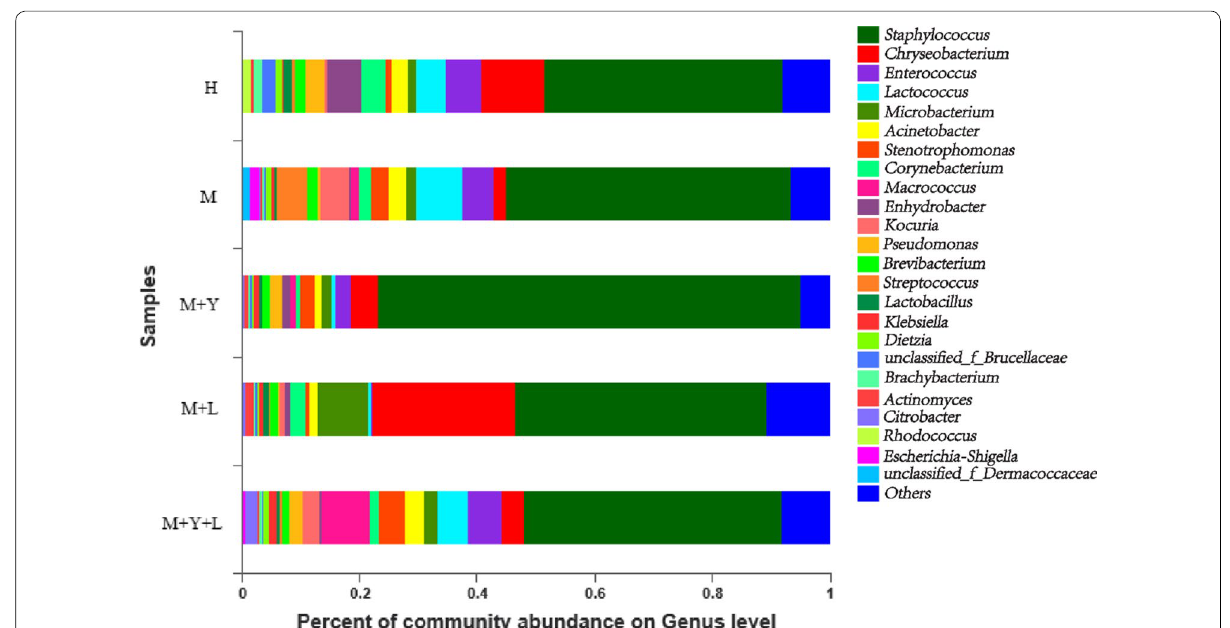
Fig. 4 The effect of treatments on the distribution of milk bacterial community at the genus level